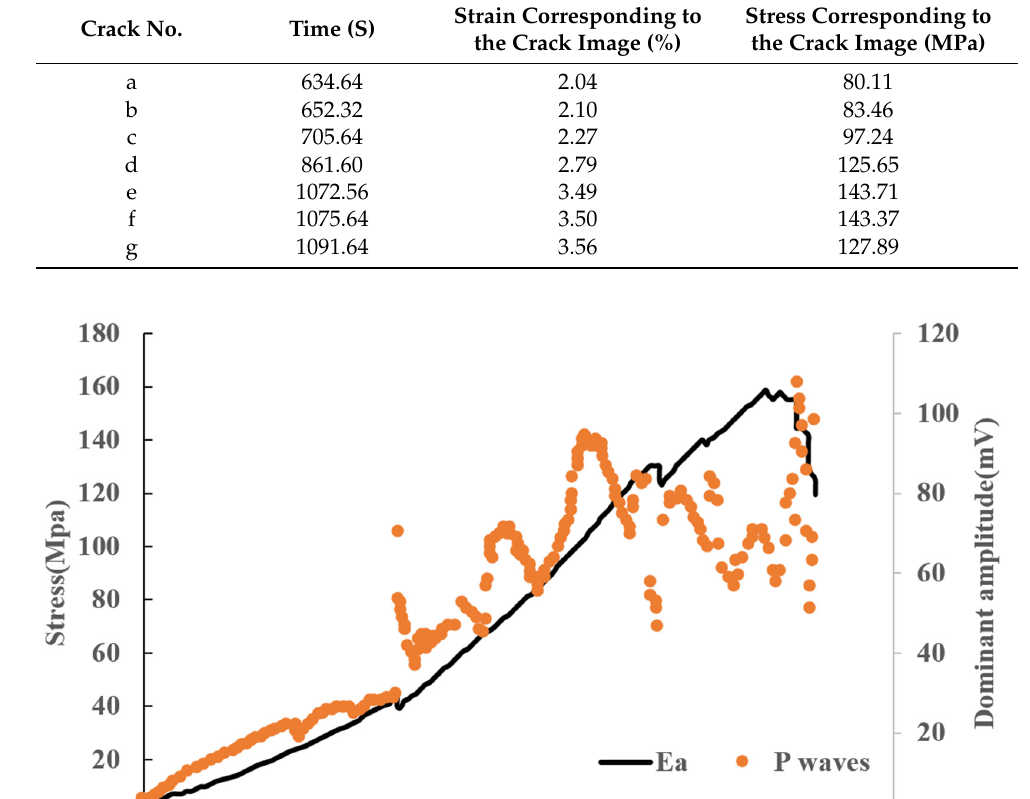
( f ) ( g ) Figure 9. Static images of cracks during shale destruction. ( a ) Crack initiation stage; ( b – d ) crack propagation stage; ( e , f ) crack penetration stage; ( g ) overall failure stage.